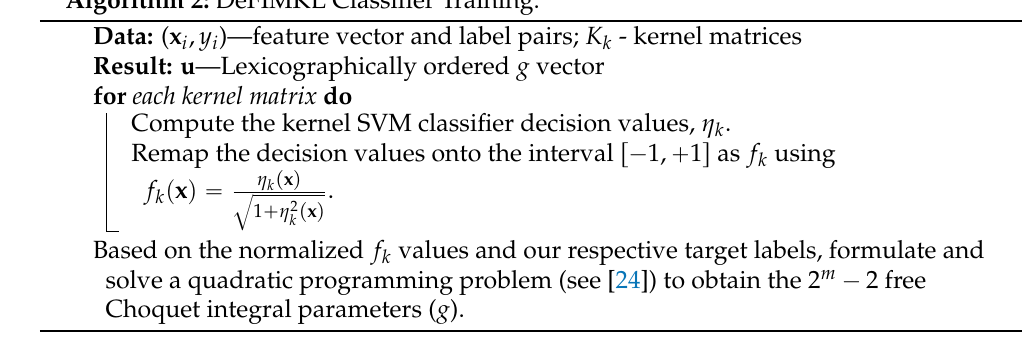
Algorithm 2: DeFIMKL Classifier Training.